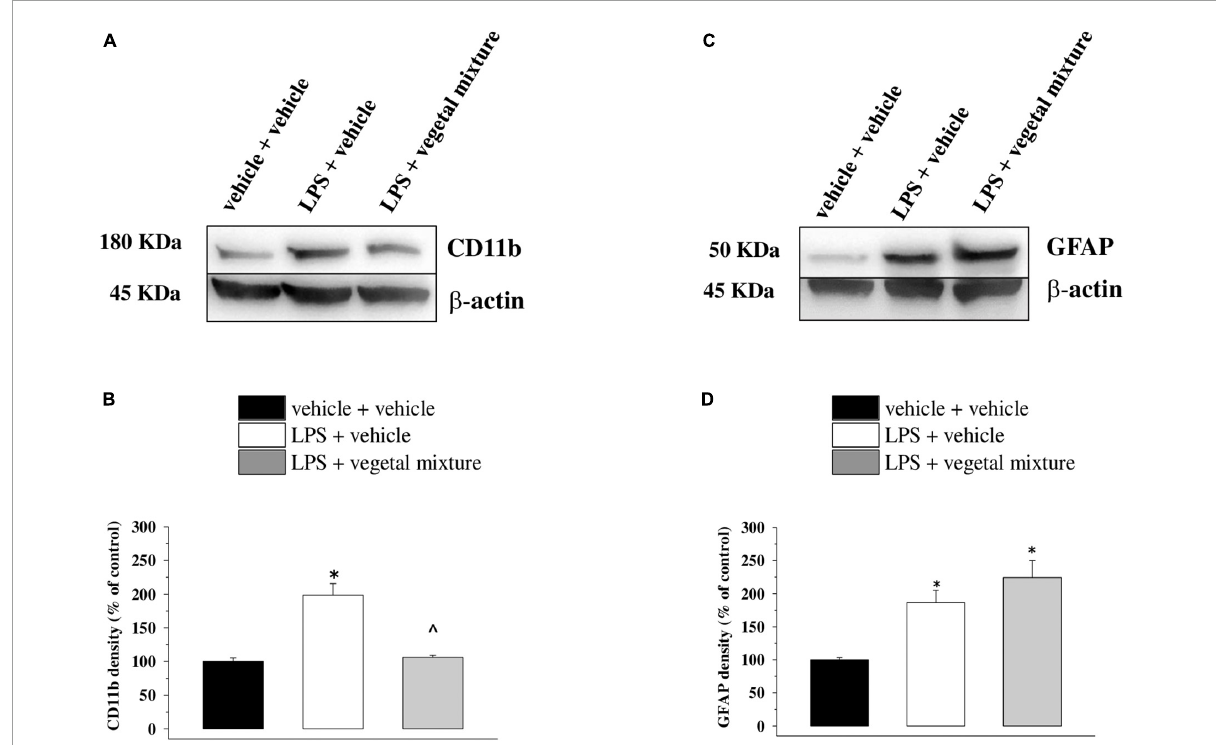
FIGURE8 Effect of a vegetal mixture on LPS-induced microglia and astrocyte activation in the prefrontal cortex. LPS treatment and sacrifice of mice were carried out as described in the legend in Figure 7 . The prefrontal cortex (PFC) was collected and analyzed for the density of the CD11b protein, a marker of microglia, and of GFAP, a marker of astrocytes. (A) Representative Western blot of the immunostainings for CD11b and β -actin, in vehicle-treated, LPS-treated, and LPS + vegetal mixture-treated mouse PFC lysates. The protein β -actin was used as an internal control. The blot is representative of the analysis of four animals for each experimental group. (B) Quantification of the change of CD11b density in the PFC in vehicle-treated, LPS + vehicle, and LPS + vegetal mixture-treated mice. Results are calculated as CD11b/ β -actin ratio and are expressed as a percentage of the respective ratio in vehicle-treated mice. (C) Representative Western blot of the immunostainings for GFAP and β -actin, in vehicle-treated, LPS-treated, and LPS + vegetal mixture-treated mouse PFC lysates. The protein β -actin was used as an internal control. The blot is representative of the analysis of four animals for each experimental group. (D) Quantification of the change of GFAP density in the PFC of mice as described above, respectively. Data are expressed as mean ± SEM of eight mice analyzed in two different experimental sets. ∗ p < 0.05 vs. vehicle-treated mice; ∧ p < 0.05 vs. LPS-treated